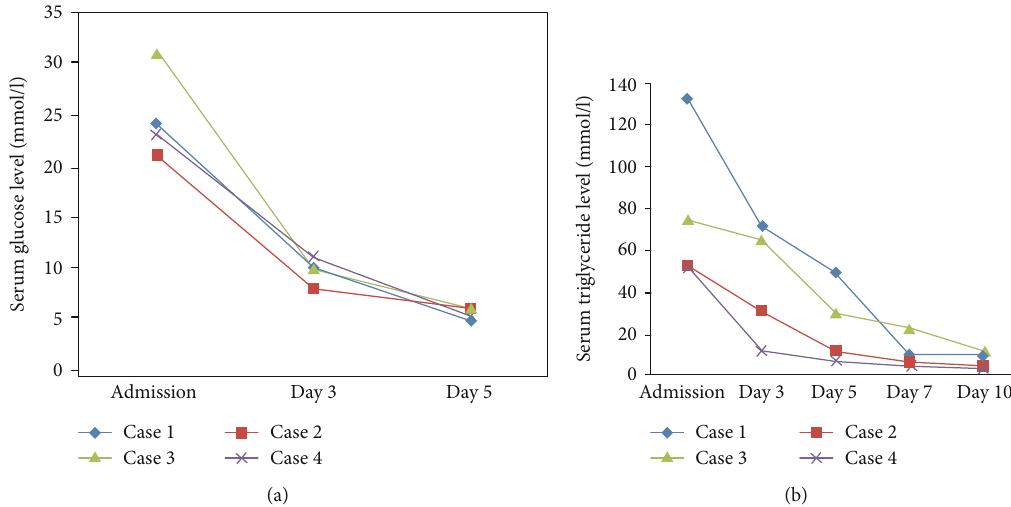
Figure 1: Evolution of serum glucose (a) and serum triglyceride (b) and level under treatment in all